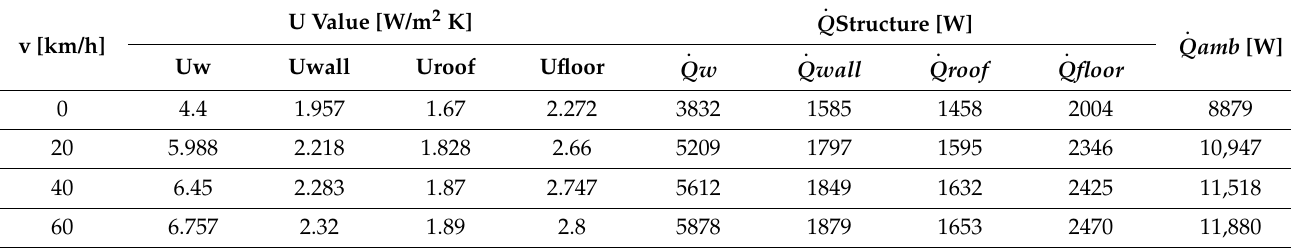
Table 5. U values and heat loss through the bus structure into the